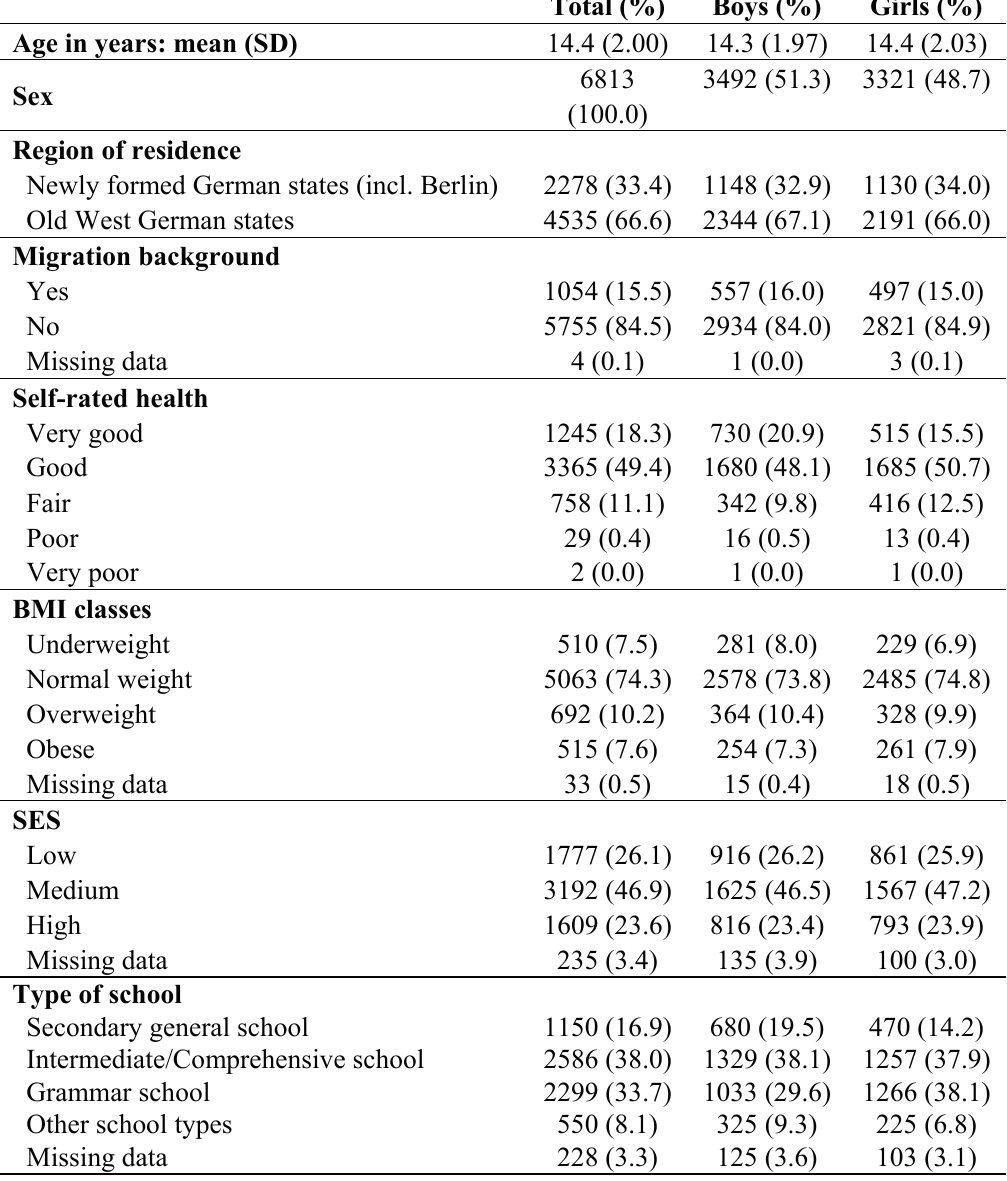
Table 1. Sociodemographic characteristics of the KiGGS sample (baseline 2003 ‒ 2006), participants aged 11 to 17 years ( n =